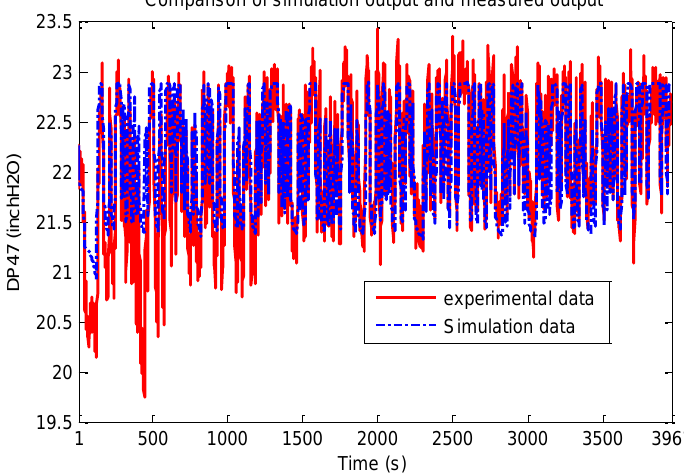
Figure 7. PRBS test - Simulation data vs. experimental data.